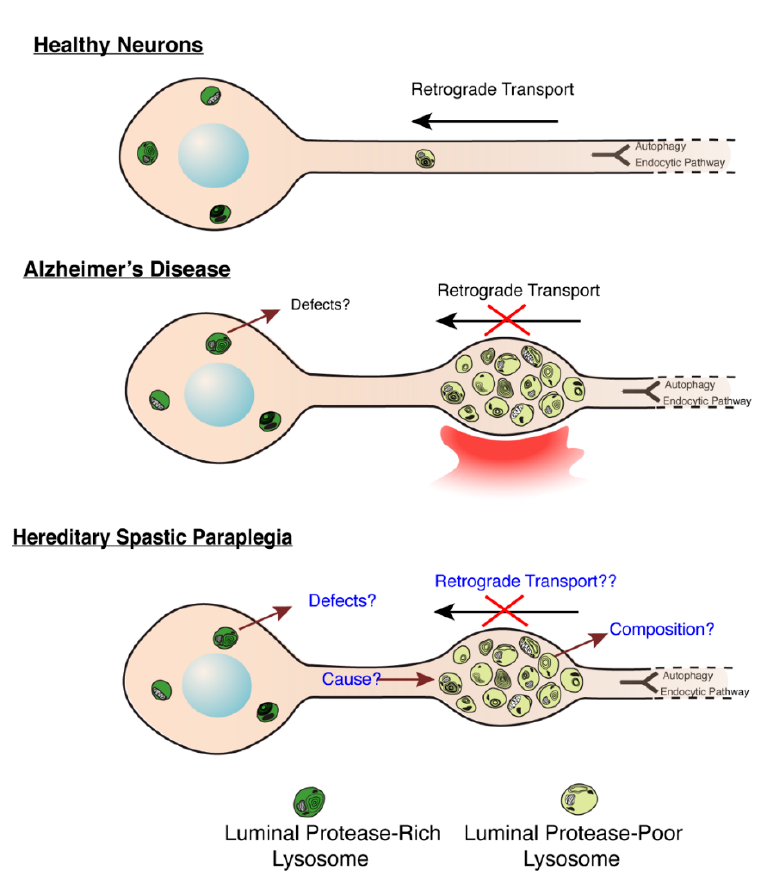
Figure 3. Molecular Mechanisms underlying lysosome dysfunction in HSP and AD . (Modified